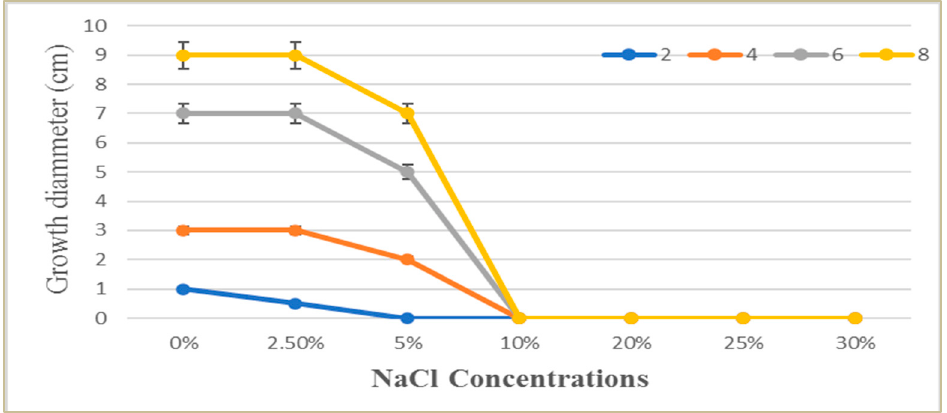
Figure 2. The effect of different NaCl solution concentrations (0.0–30%) on the growth of P. chryso- genum MZ945518 at different incubation times (2, 4, 6 and 8